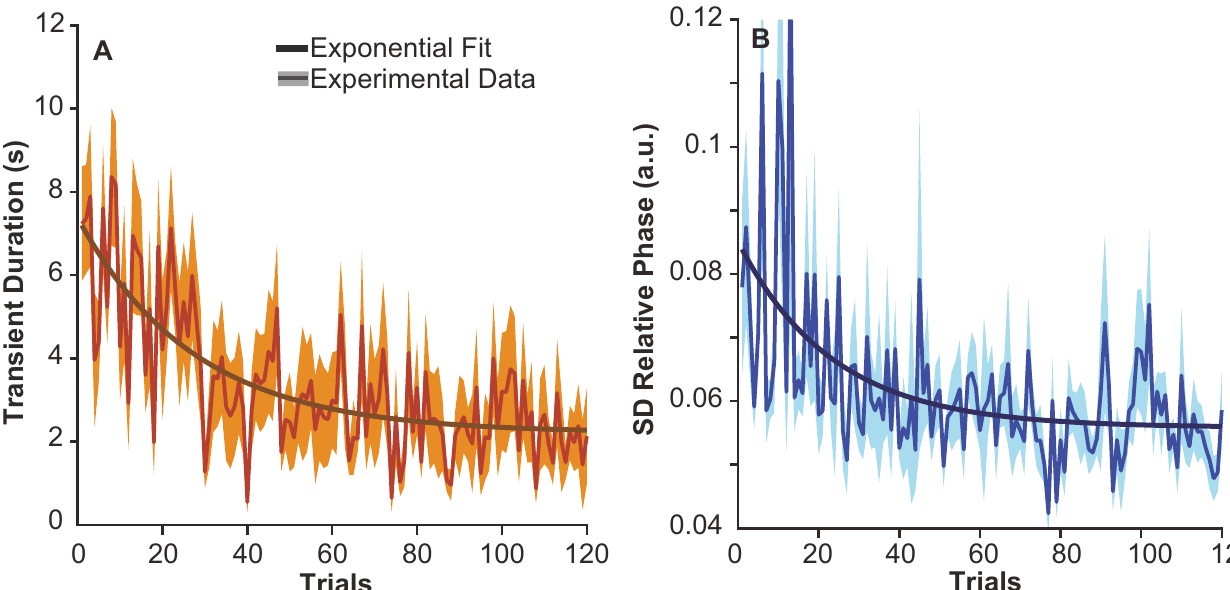
Fig 6. Transient duration and stability of the steady state: A. Transient durations of 11 subjects across 120 trials. The solid line represents the mean, the shaded area around this line represents the standard error across subjects. The dark solid line represents the exponential function fitted to the data: A = 5.174, τ = 27.29 and B = -2.963, and R 2 = 0.56. B. Standard deviations of the relative phase between ball and cup position across subjects during the steady state interval. The data was fit with the parameters: A = 0.03, τ = 23.43 and B = 0.03, and R 2 =